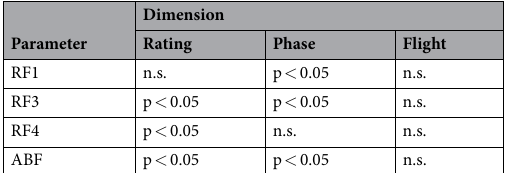
Average breathing frequency exhibits similar significant trend between phases with